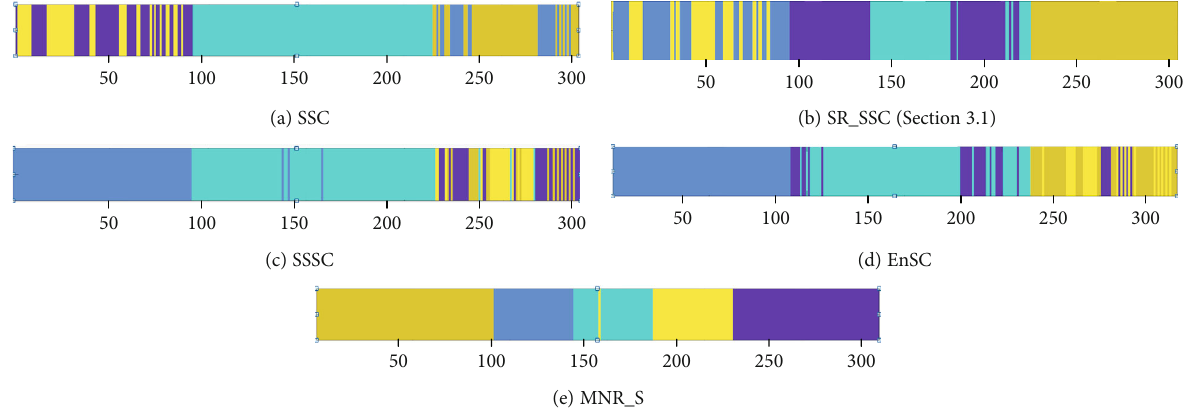
Figure 8: Clustering result of ‘ shark+yoga+pickup+stretch+dance. ’ e ff ect in the current experimental dataset. The dictionary set of the SSSC, with the size of 30 β , adopts the random uniform selection method, where β is the number of nonrigid bodies.